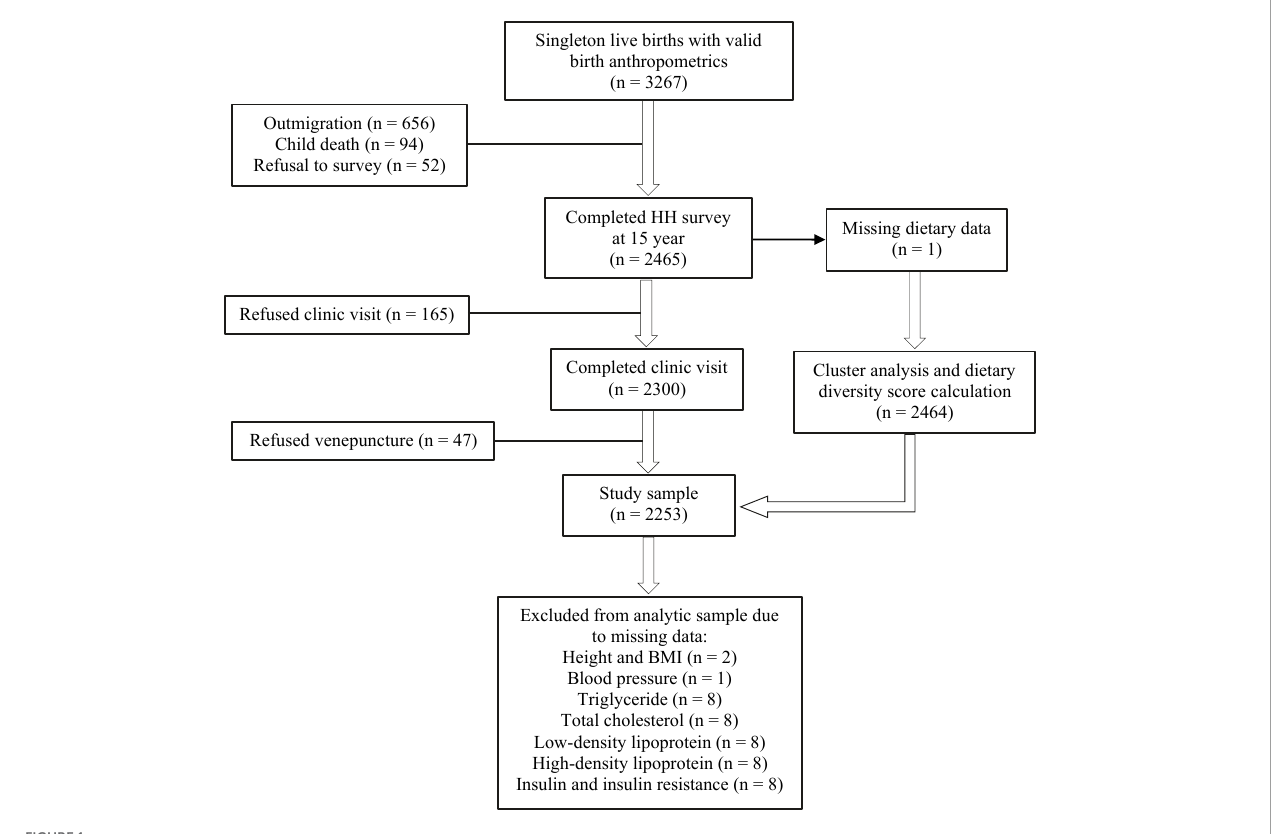
FIGURE1 Flowchart for inclusion of Maternal and Infant Nutrition Intervention in Matlab (MINIMat) adolescents into the present study. HH, household.